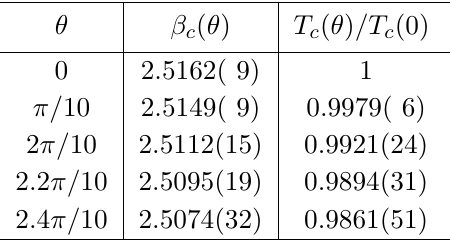
Table 2 . The numerical results for β c ( θ ) and T c ( θ ) /T c (0)